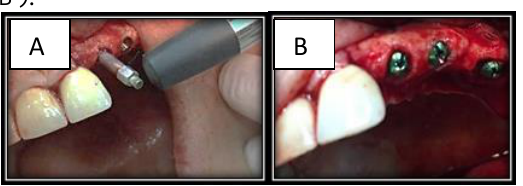
Figure 5: A-ISQ measurement, B-cover screw placement.